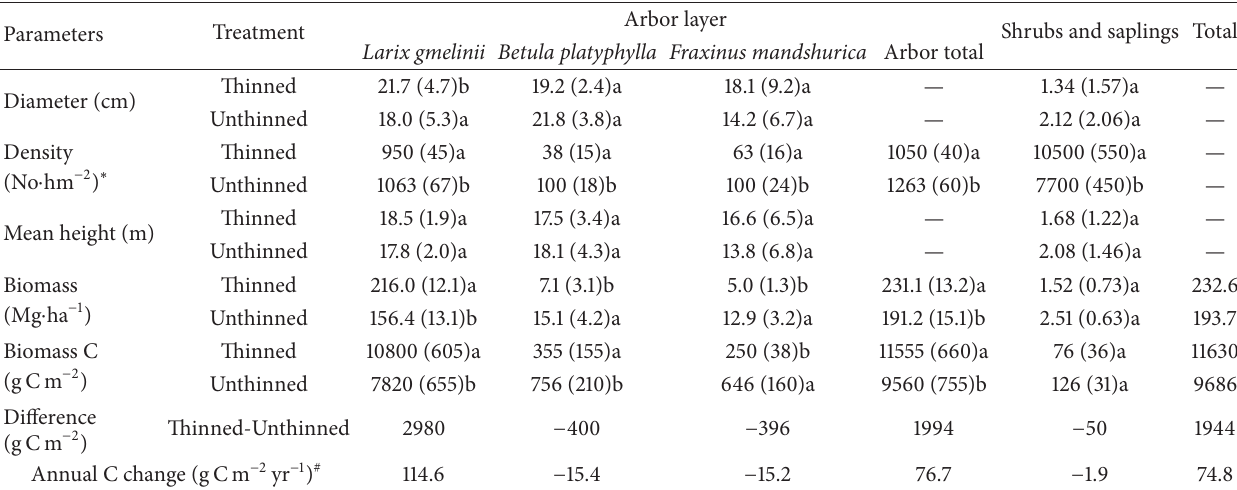
Table 1: Long-term thinning effects on the growth and biomass C accumulation of species found in larch plantations. Values in parentheses are standard